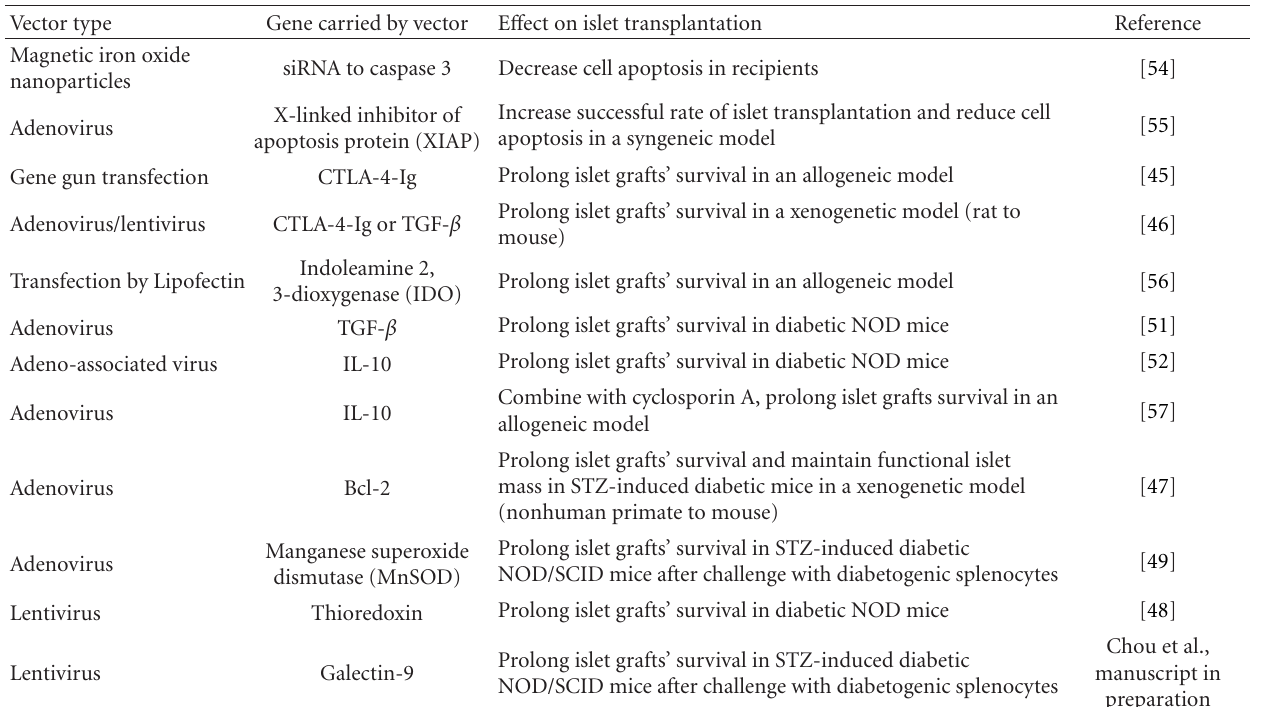
Table 2: Genetically engineered islets for transplantation